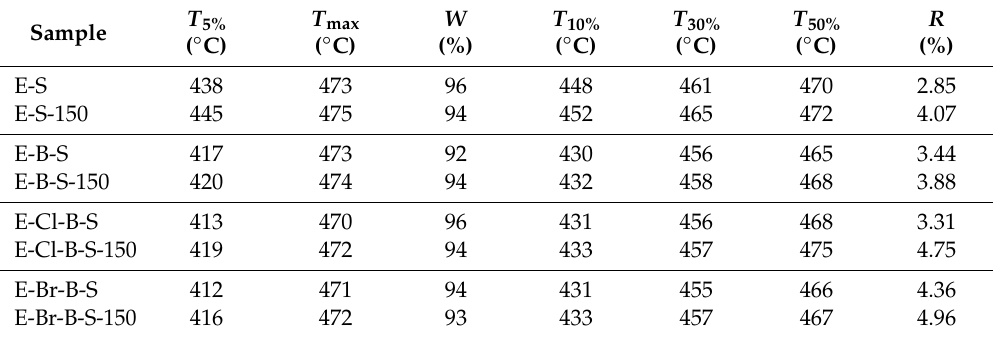
Table 4. Summary of thermogravimetric analyses (TGA) results for the EPDM composites.